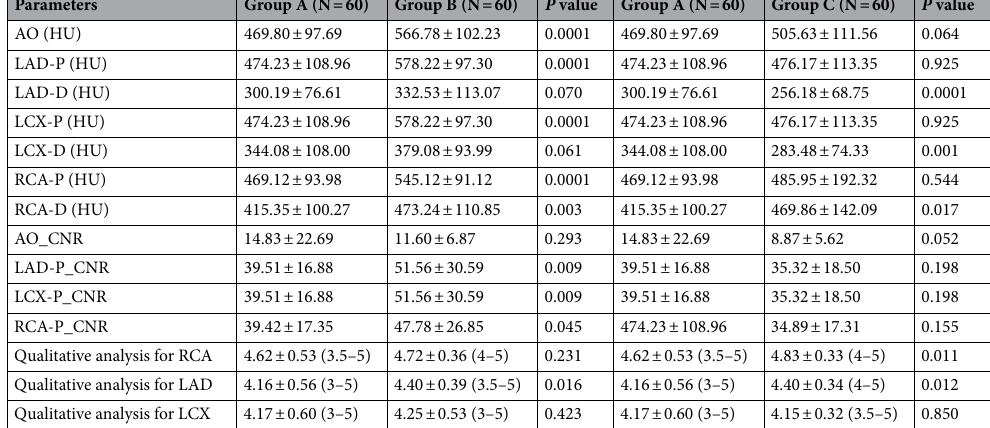
Table 4. Comparison of quantitative and qualitative analysis results. AO, aortic root; HU, Hounsfield units; LAD-D, distal left anterior descending; LAD-P, proximal left anterior descending; LCX-D, distal left